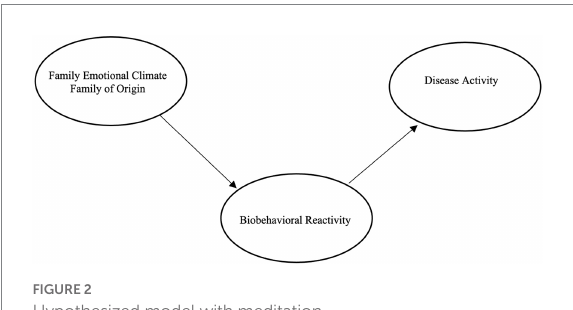
FIGURE 2 Hypothesized model with